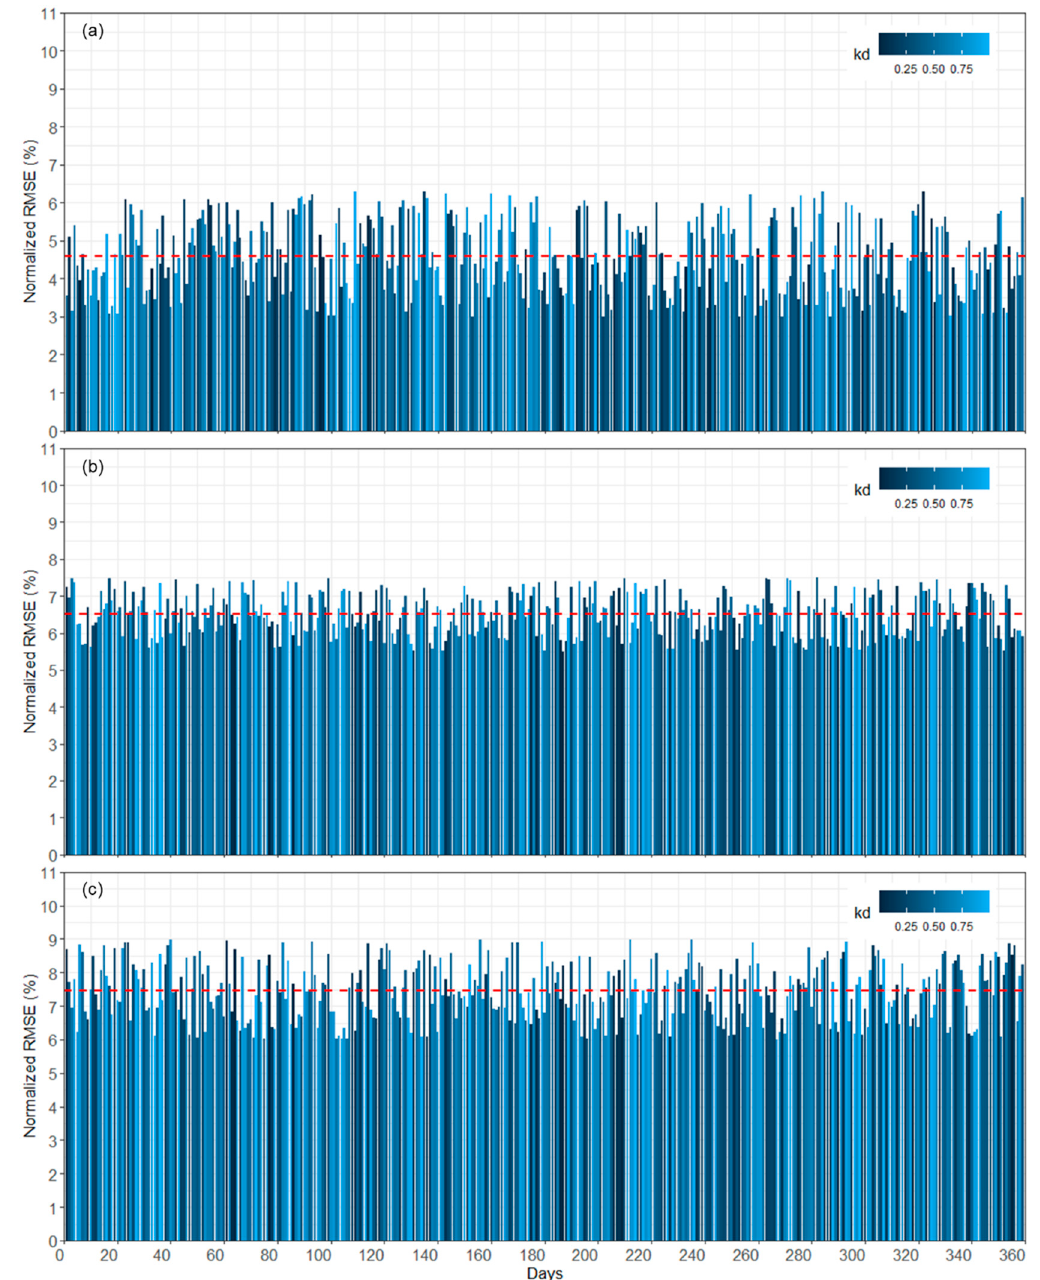
Figure 5. Day-ahead photovoltaic (PV) power production forecasting accuracy given by the daily nRMSE when applying over the test set evaluation period the optimally trained machine learning models of: ( a ) Bayesian neural network (BNN); ( b ) support vector regression (SVR); ( c ) regression tree (RT).The red dashed line indicates the average nRMSE over the test set evaluation